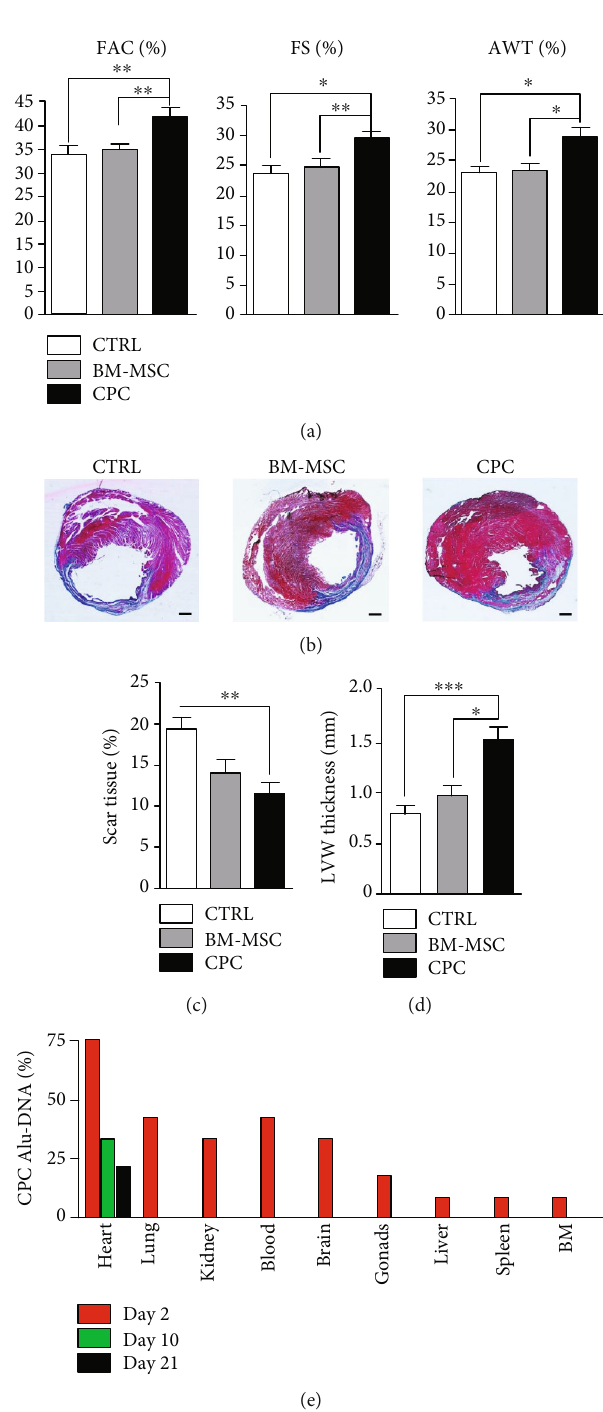
Figure 1: Improvement of left ventricular function in CPC-treated animals 4 weeks after transplantation. (a) Quanti fi ed values of fractional area change (FAC, %), fractional shortening (FS, %), and anterior wall thickening (AWT, %) from the control, BM-MSC, and CPC animal groups measured in 2D and M-Mode imaging 4 weeks after myocardial infarction ( n = 10 in each group). (b) Representative images of heart sections from infarcted rats stained with Masson ’ s trichrome. Fibrotic area in the left ventricle is stained in blue. (c) Quanti fi cation of the fi brotic area represented as the percentage scar tissue. (d) Quanti fi cation of the left ventricular wall (LVW) thickness in millimeters. Data are represented as mean ± SEM . ∗ p < 0 : 05 , ∗∗ p < 0 : 01 , and ∗∗∗ p < 0 : 001 . (e) Detection of transplanted CPCs after transplantation in infarcted rats at di ff erent time points. Percentage of rats in which human Alu-DNA was detected in the indicated organs on days: 2 (red), 10 (green), and 21 (black) after myocardial infarction. Scale bar = 1 mm